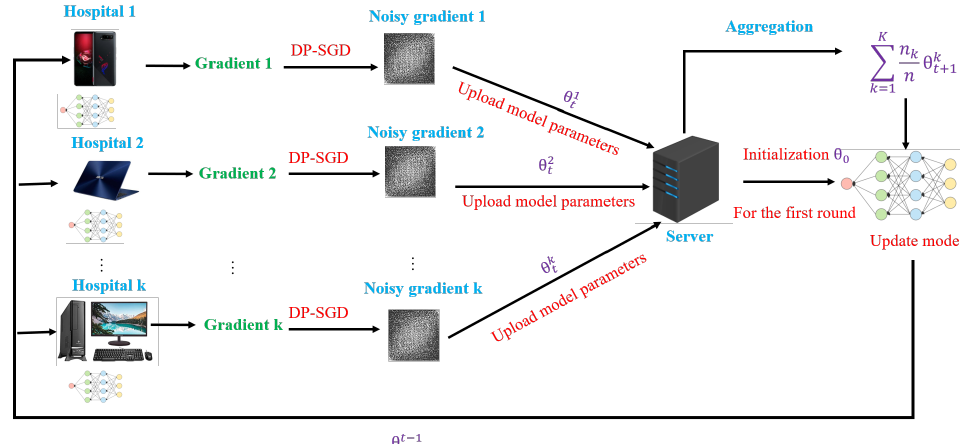
Figure 1. Federated COVID-19 detection system